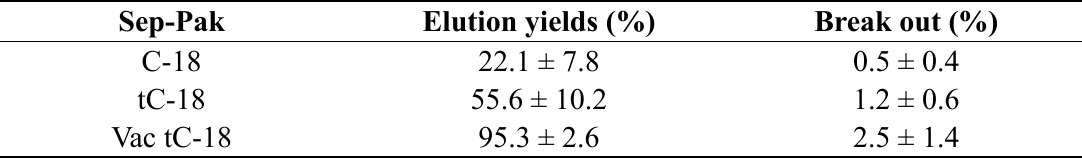
Table 1. Elution and break-out efficiencies with different Sep-Pak